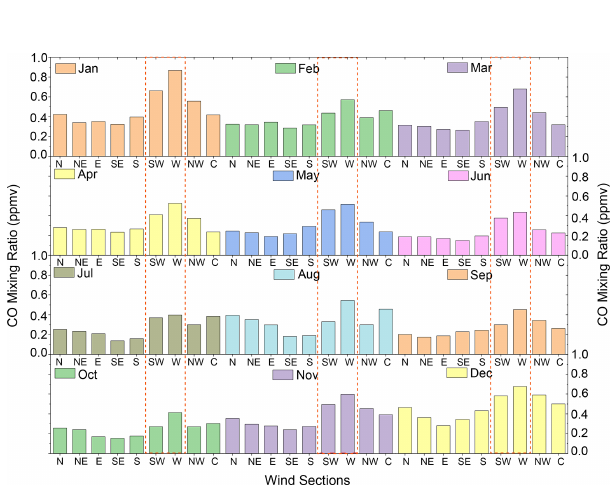
Figure 3. Monthly mean CO mixing ratios under north (N), north- east (NE), east (E), southeast (SE), south (S), southwest (SW), west (W), northwest (NW) and calm (C) wind conditions at the Dongtan (DT) site, a remote rural site near Sheshan Island (SSI), from 2012 to 2017.